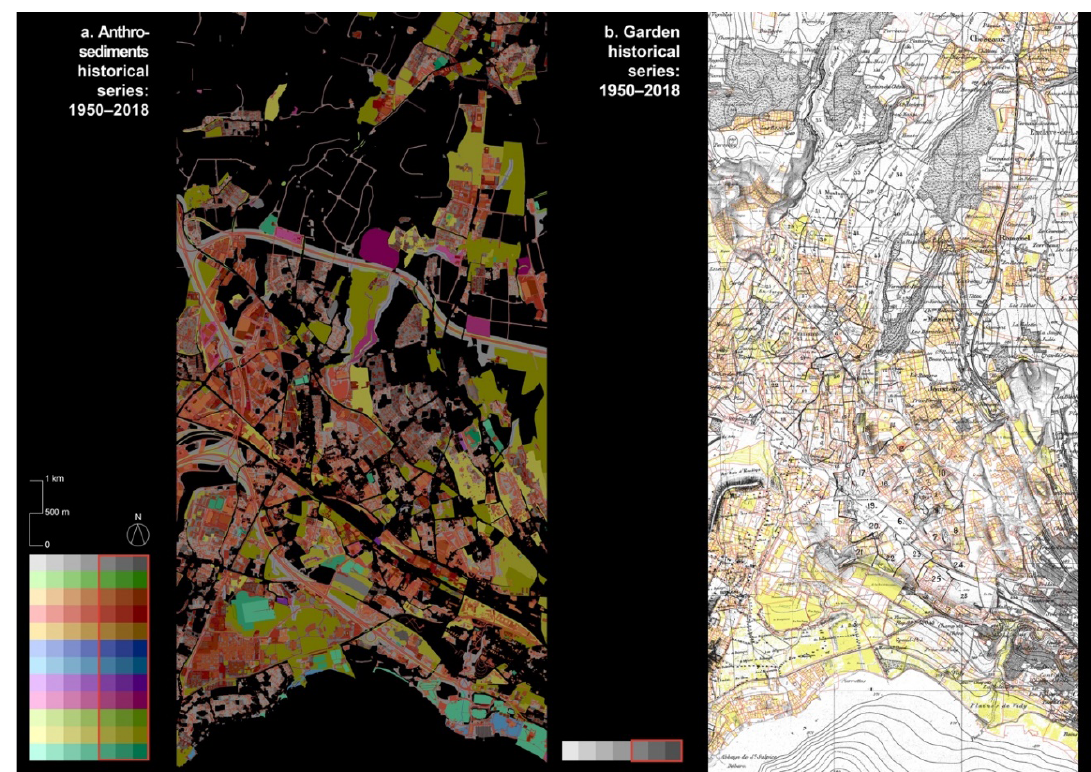
Figure 10. Second half of the 20th century: Historical map series of base layers II and III. Source: Authors.